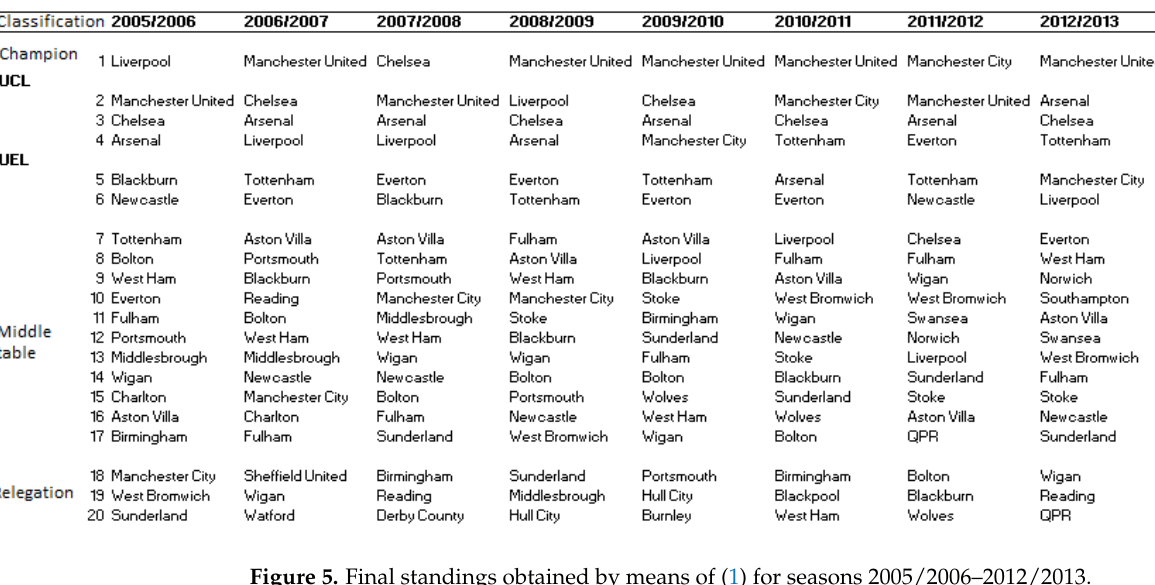
Figure 5. Final standings obtained by means of (1) for seasons 2005/2006–2012/2013.